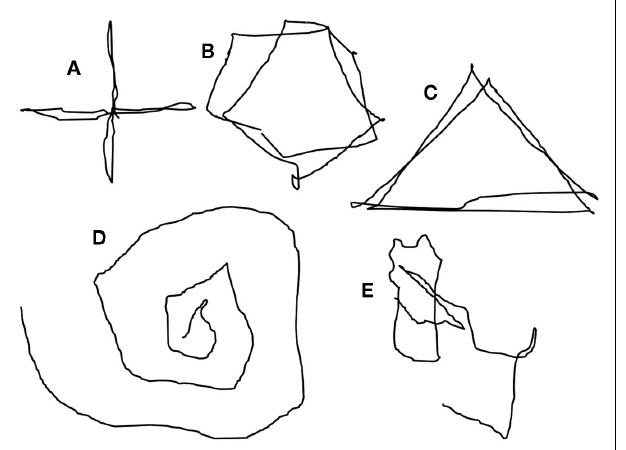
FIGURE 3 | Reconstruction to depict the illusion of movement, in darkness, of a point of light during voluntary attempted movements of gaze. The perceived trajectories of the illusory movement of the light are, consecutively: cross (A) , circle (B) , triangle (C) , Archimedes’ spiral (D) , and signature (Dy[lan]) (E) .The supplementary material shows an animation of this depiction.